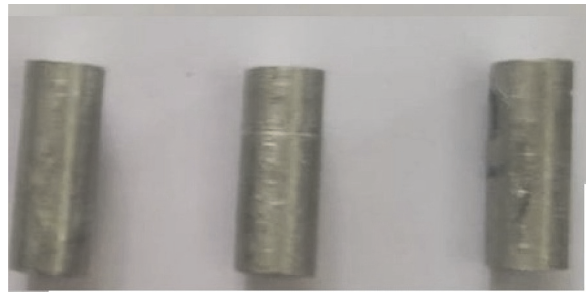
Figure 6: Compression specimen.